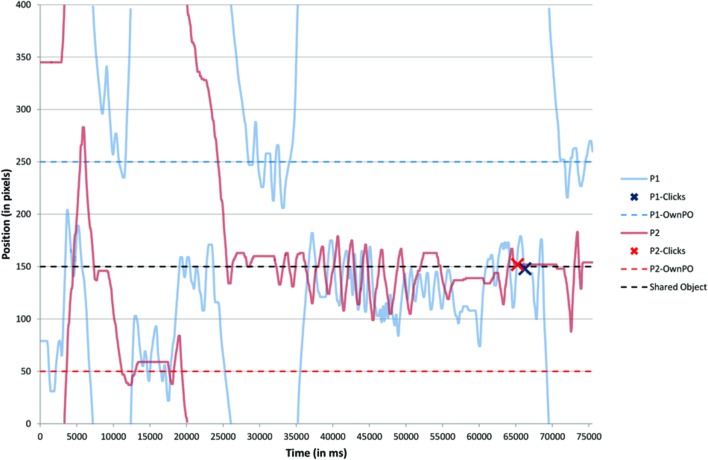
Time series of an illustrative trial. The perceptual trajectories of a pair of participants can be spotted across the one-dimensional space (y-axis) over the 75 s (x-axis) of a given trial (i.e., the second trial of the ‘Mono’ condition). Solid light blue and light red lines plot the position of the two participants (P1 and P2), while the dotted blue and red lines represent the position of their respective private object (P1-OwnPO and P2-OwnPO). The dotted black line plots the position of the Shared Object. In this trial, both participants clicked on the Shared Object (blue and red crosses).